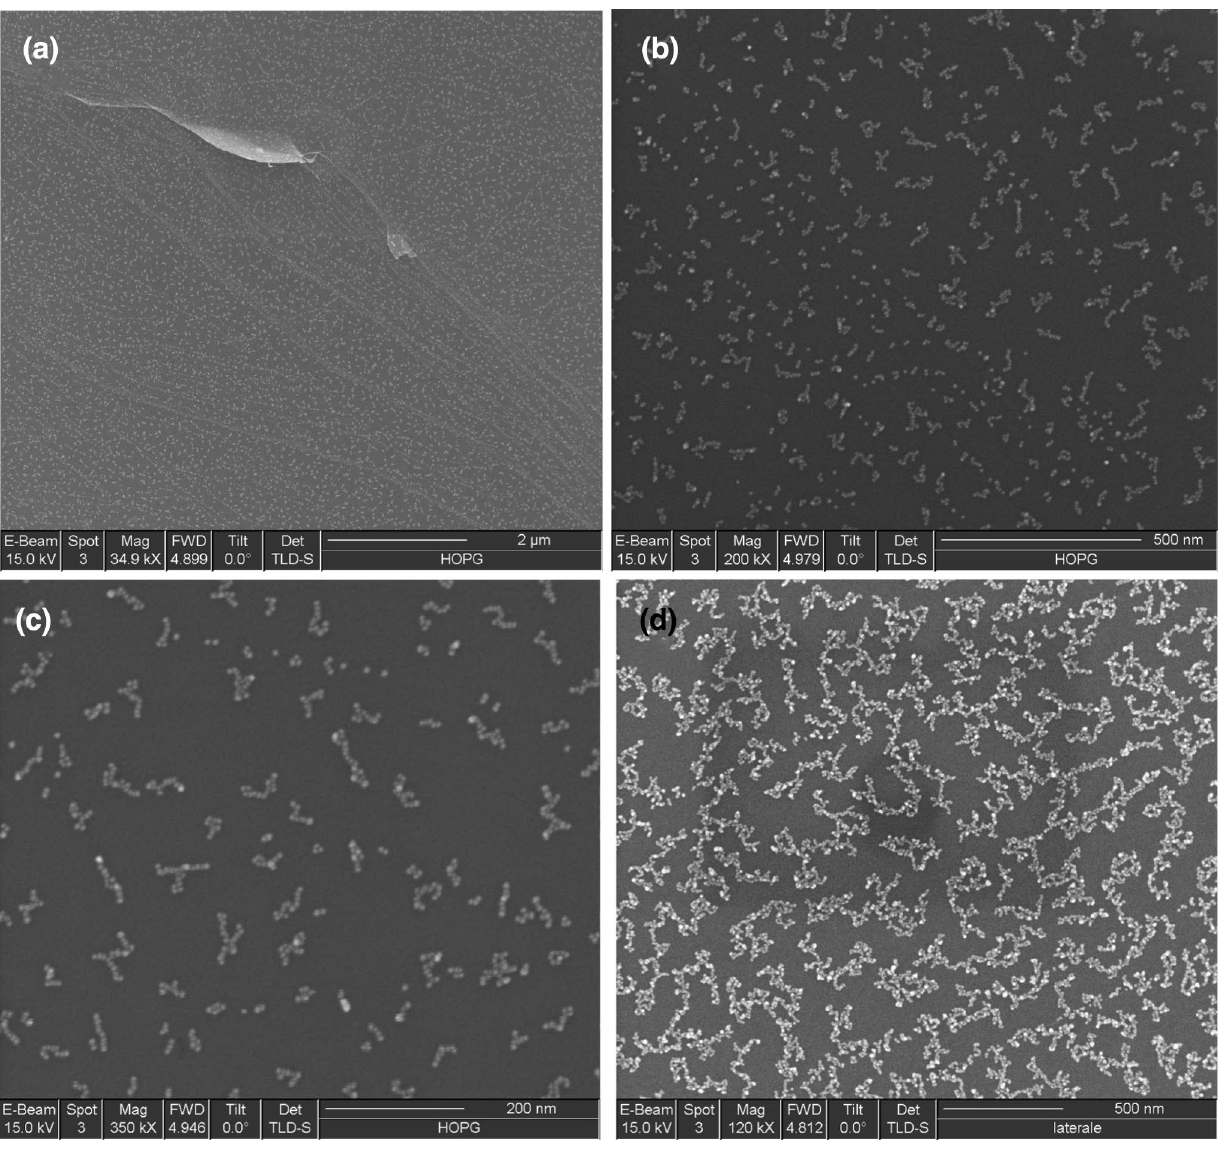
with M = 200 kX. c same as ( b ), with M = 350 kX. d SEM image taken from a sample with a fractional coverage C = 15% after annealing in atmosphere at T = 500 K for t = 30 min, M = 120